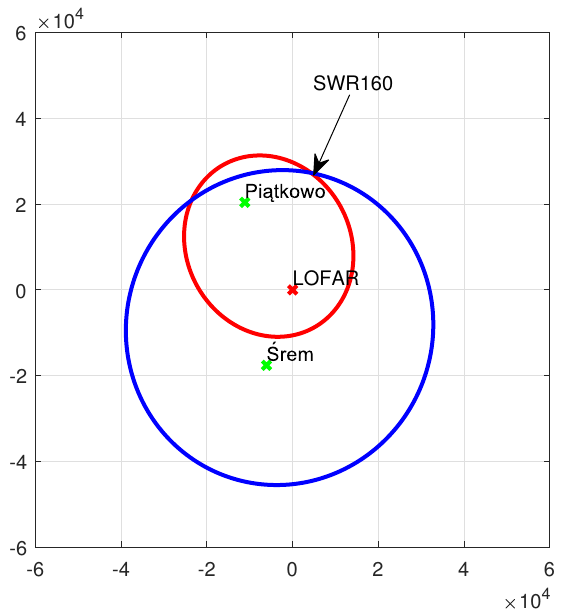
Figure 22. Two ellipses computed based on the SWR160 plane’s bistatic ranges from two transmitter stations.